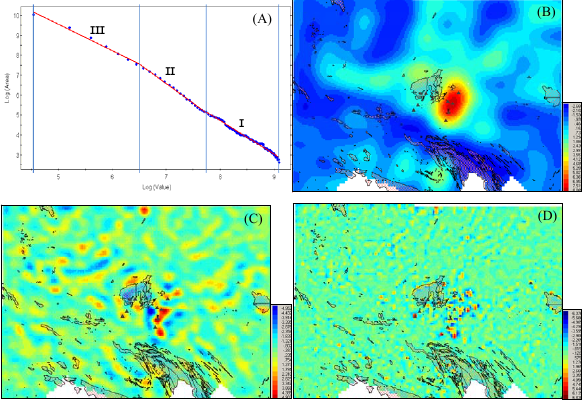
Fig. 3. (A) Plot showing the S-A relationship between the spectral energy density (S) and area (A). The dots are the calculated results and the three red lines labeled as I, II, and III were fitted by the LS method. The logarithmic transformations are base ten. (B) –(D) Decomposed background, anomalous and noise components of As using filters I, II and III, respectively. The black polygons are mapped intrusions. The black triangles are tin mineral deposits.